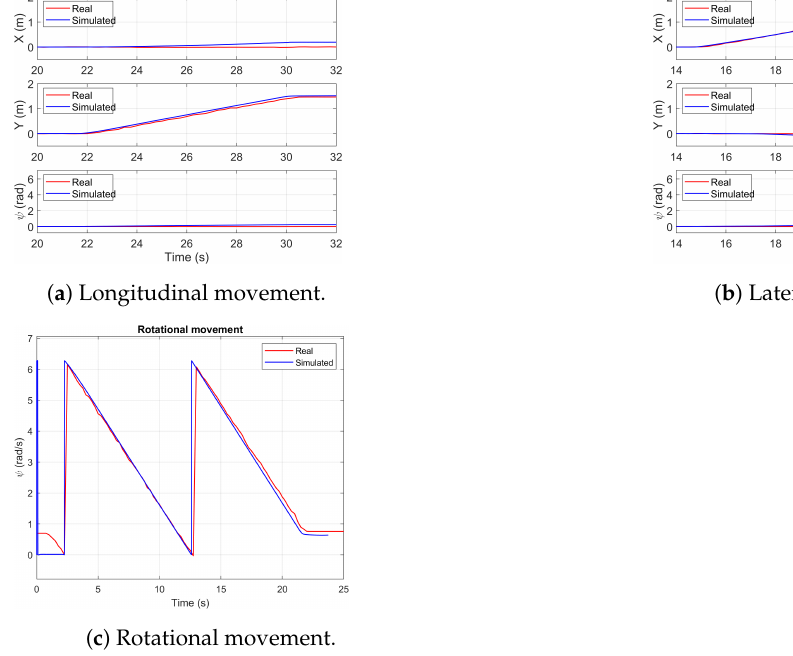
Figure 10. Comparison of results between the simulator and real robot